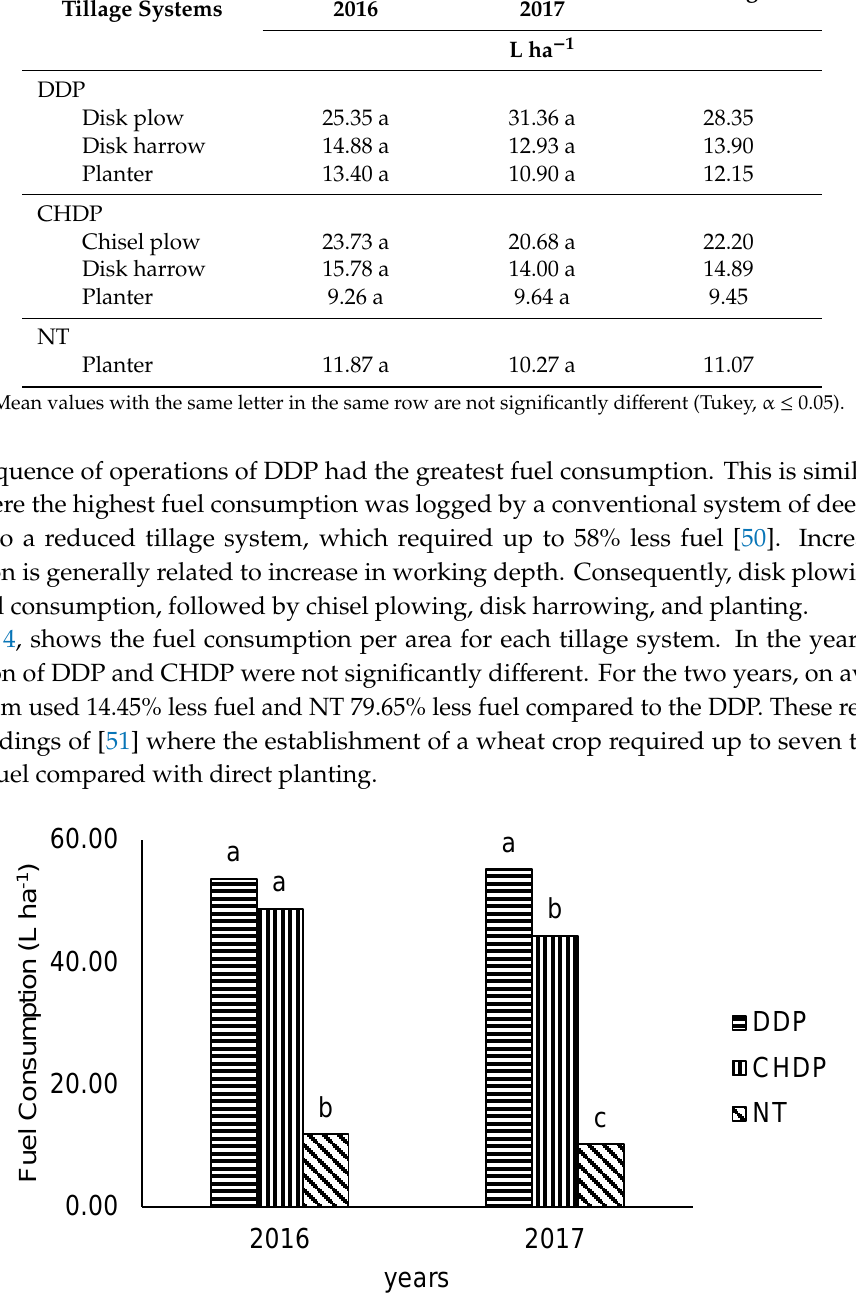
Figure 4. Fuel consumption per area for each tillage system; different letters in columns in the same year are significantly different (Tukey, α ≤ 0.05).